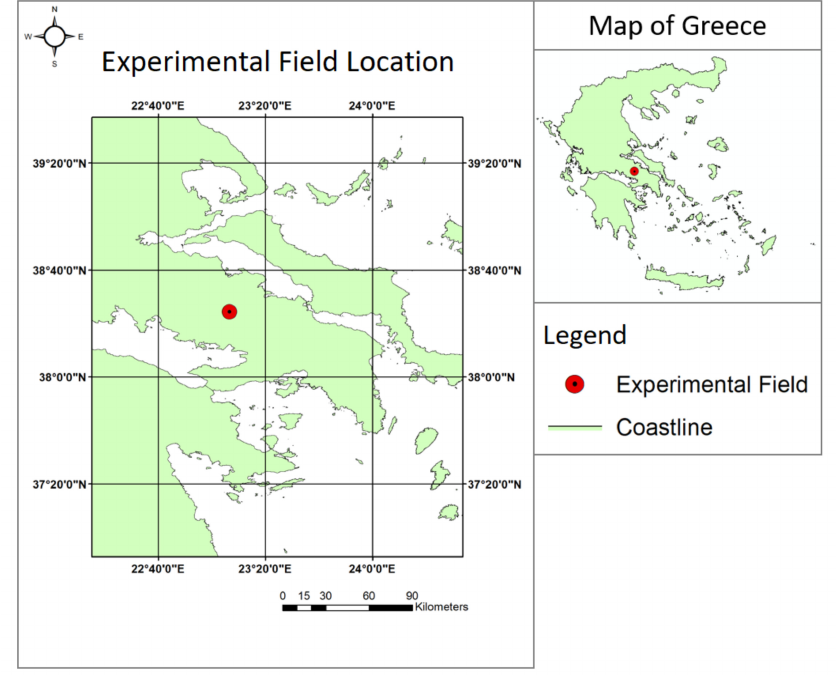
Figure 1. The relative location of the experimental area for this study, located in Aliartos, Greece. The geographical coordinates of the area are 38 ◦ 23 (cid:48) 40 (cid:48)(cid:48) N, 23 ◦ 6 (cid:48) 10 (cid:48)(cid:48) E, and the elevation is 265 m above sea level